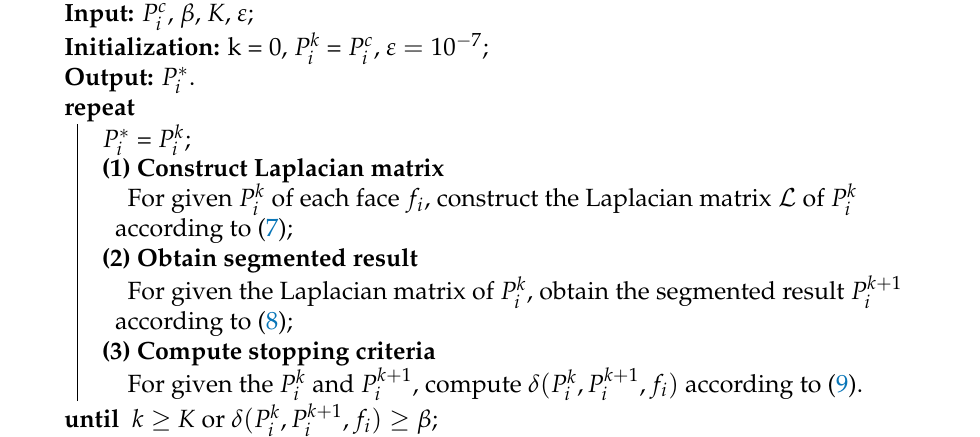
Algorithm 1: Adaptive consistent neighborhood